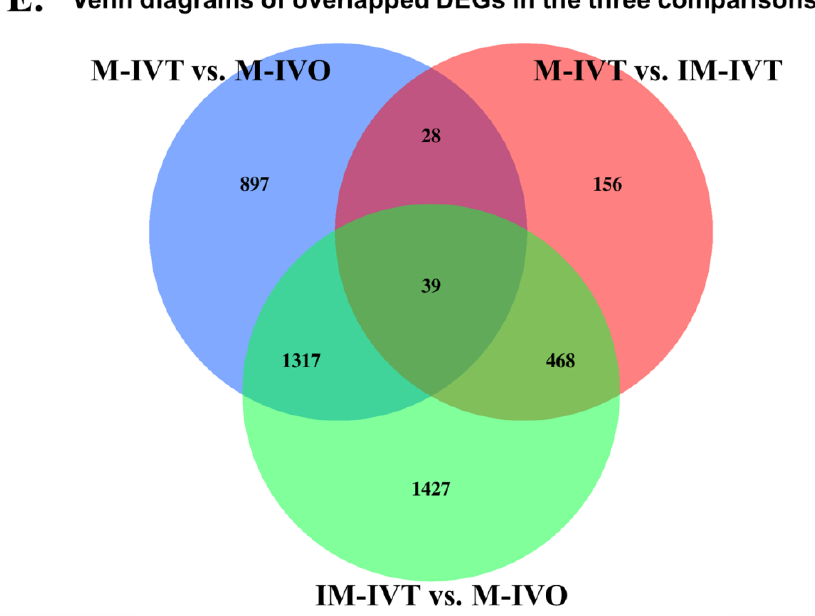
Figure 2. Different scale of DEGs. Volcano plot of differentially regulated genes in oocytes between M-IVT and IM-IVT ( A ), between M-IVT and M-IVO ( B ). Each point in the figures represents a gene. The X -axis shows log 2 (Fold changes) and the Y -axis shows – log 10 (p-value). The vertical lines show thresholds for log 2 ratio larger than 1 or lower than -1. The horizontal line shows threshold for p-value < 0.05. The gray points represent gene exhibiting no significant differential expression between IM-IVT and M-IVO or between M-IVT and IM-IVT; the red points represent genes that are upregulated and the blue points represent genes that are downregulated; the green points represent genes that are related to mitochondrion. Gene ontology (GO) categories enrichment analysis of dif- ferentially expressed genes in oocytes between M-IVT and IM-IVT ( C ), between M-IVT and M-IVO